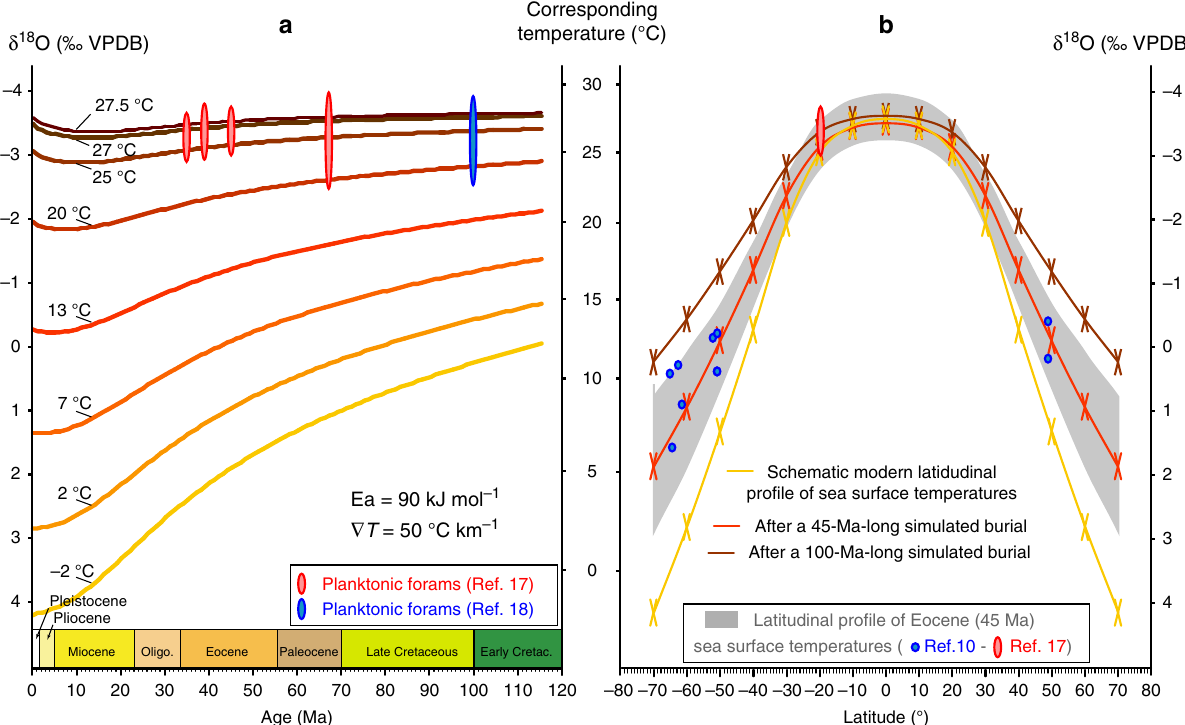
Fig. 4 Assessment of the impact of burial-induced O isotope re-equilibration on the planktonic foraminifera O isotope records. a Planktonic foraminifera O isotope data from Pearson et al. 17 (Tanzania, Paleolatitude ∼ 20° S) and from Wilson and Norris 18 (ODP Site 1052, Paleolatitude ∼ 20° N) are shown together with the results from numerical simulations run with a geothermal gradient of 50 °C km − 1 and a diffusion activation energy of 90 kJ mol − 1 , assuming an ice-free ocean ( δ 18 O = − 1 ‰ VSMOW) and a temperature of 3.5 °C at the water – sediment interface. The curves represent the present-day O isotope compositions of fossil planktonic foraminifera tests formed in equilibrium with seawaters at − 2, 2, 7, 13, 20, 25, 27 and 27.5 °C. These temperatures roughly correspond to those of surface waters in the modern ocean at 70, 60, 50, 40, 30, 20, 10 and 0° latitude 10 . b Latitudinal pro fi les of the O isotope compositions of the planktonic foraminifera for different simulated burial durations: a latitude gradient similar to the modern one (yellow curve) will fl atten substantially after 45 Myr (red curve) and 100 Myr (brown curve) in response to the burial-induced O isotope re-equilibration. Also shown are the Eocene (45 Ma) tropical planktonic foraminifera O isotope data from Pearson et al. 17 (red) and the high-latitude planktonic foraminifera O isotope data from Zachos et al. 10 (grey). The temperature conversion is from Anderson and Arthur 3 and assumes an ice-free ocean with a seawater δ 18 O = − 1